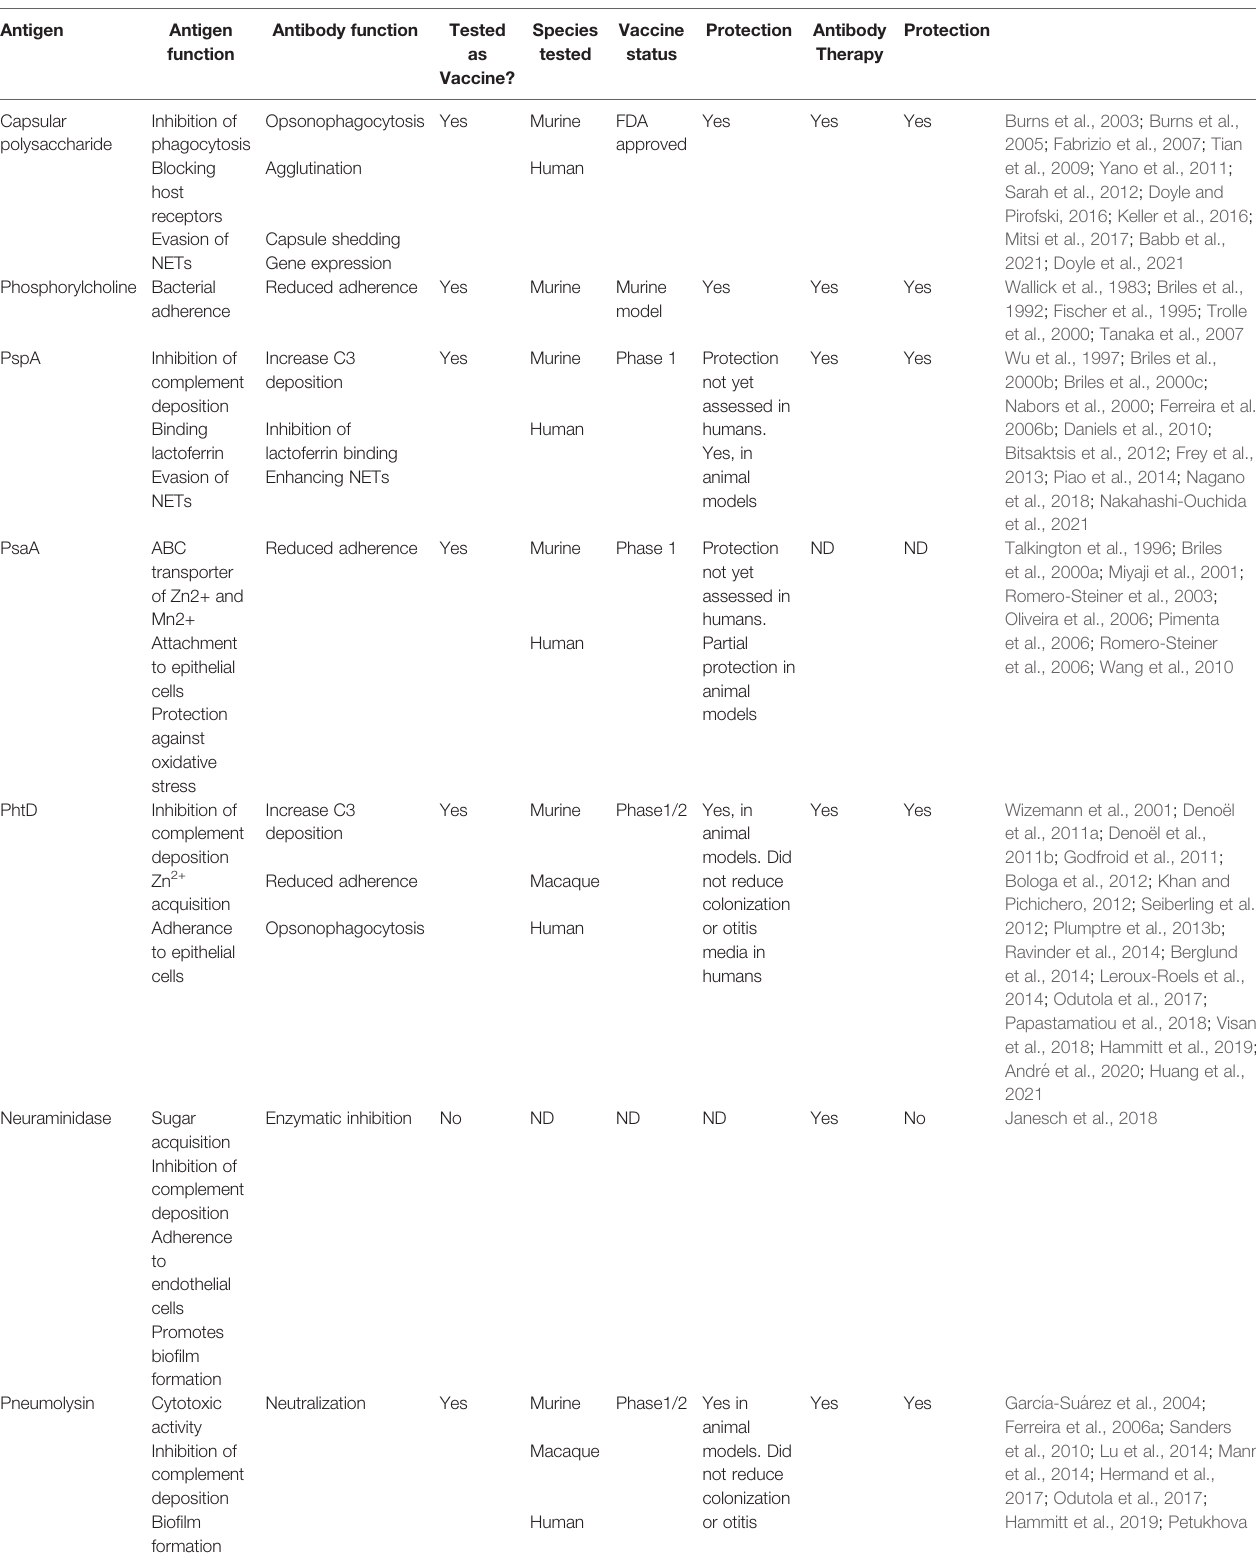
TABLE 1 | Antigens evaluated in clinical trials and animal